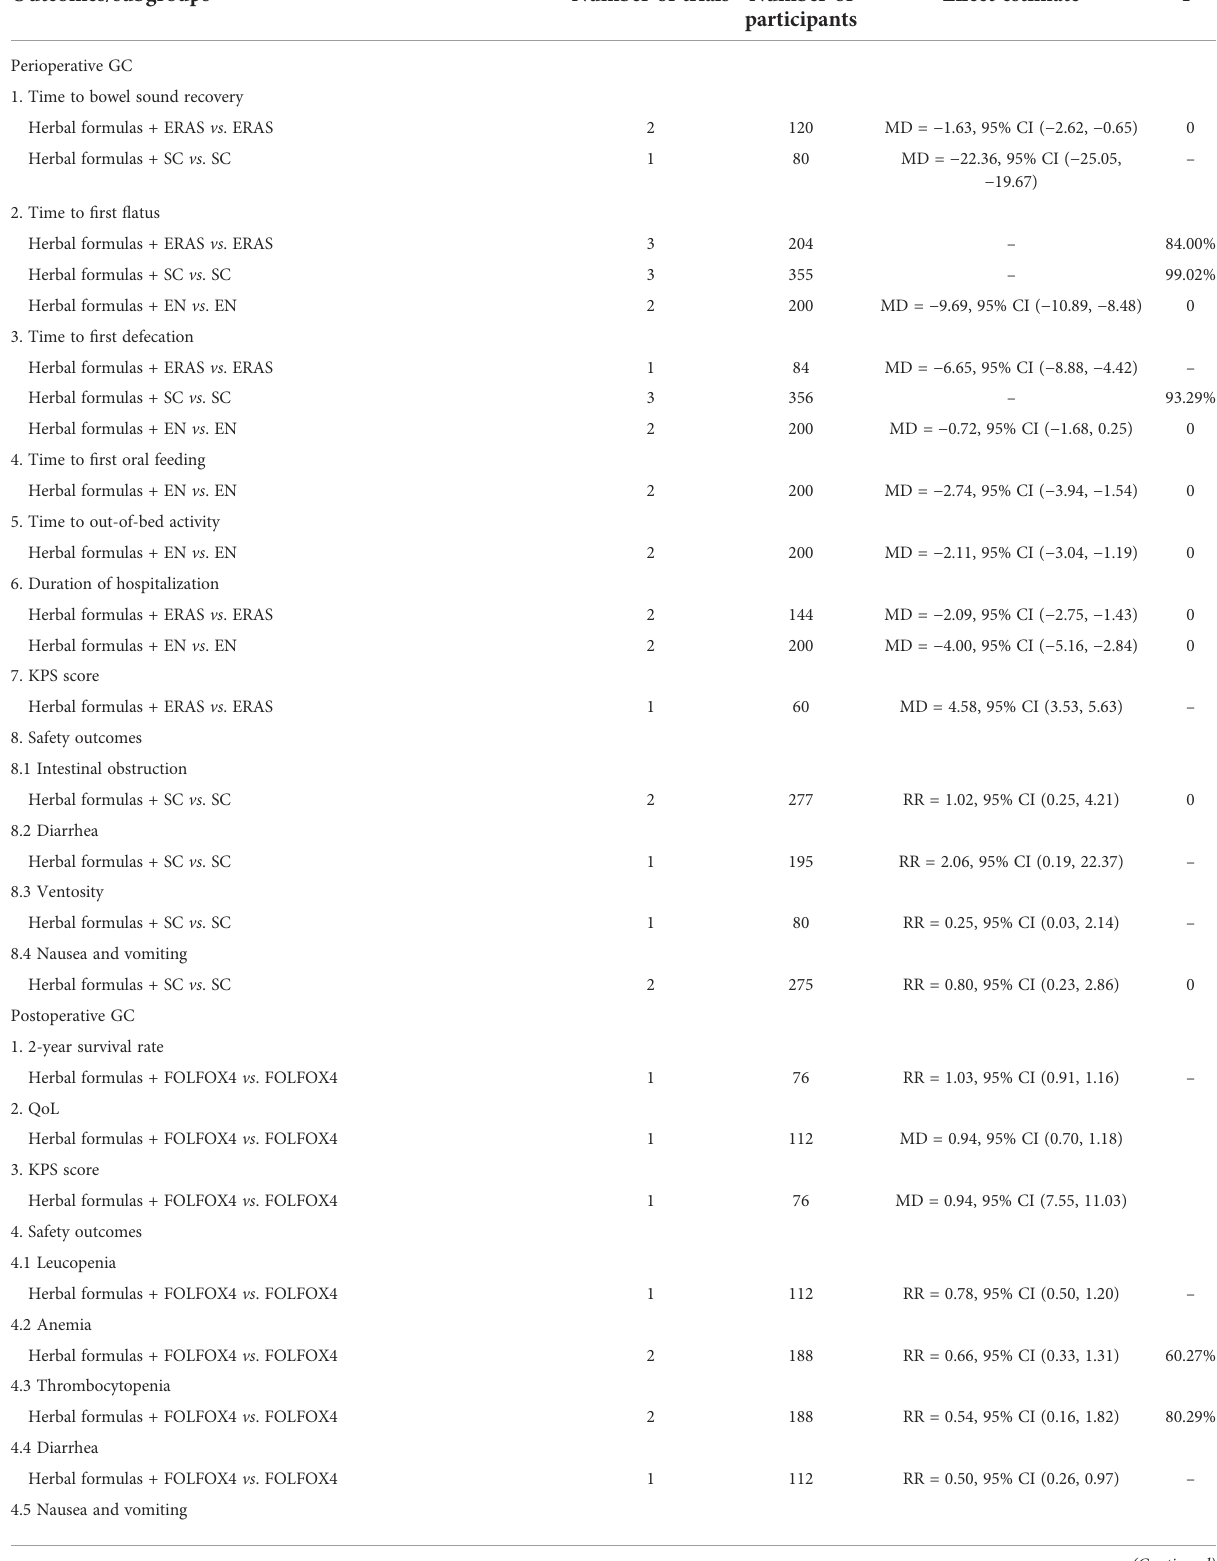
TABLE 3 Results of ef fi cacy and safety of herbal formulas with function of gut microbiota regulation in GC and